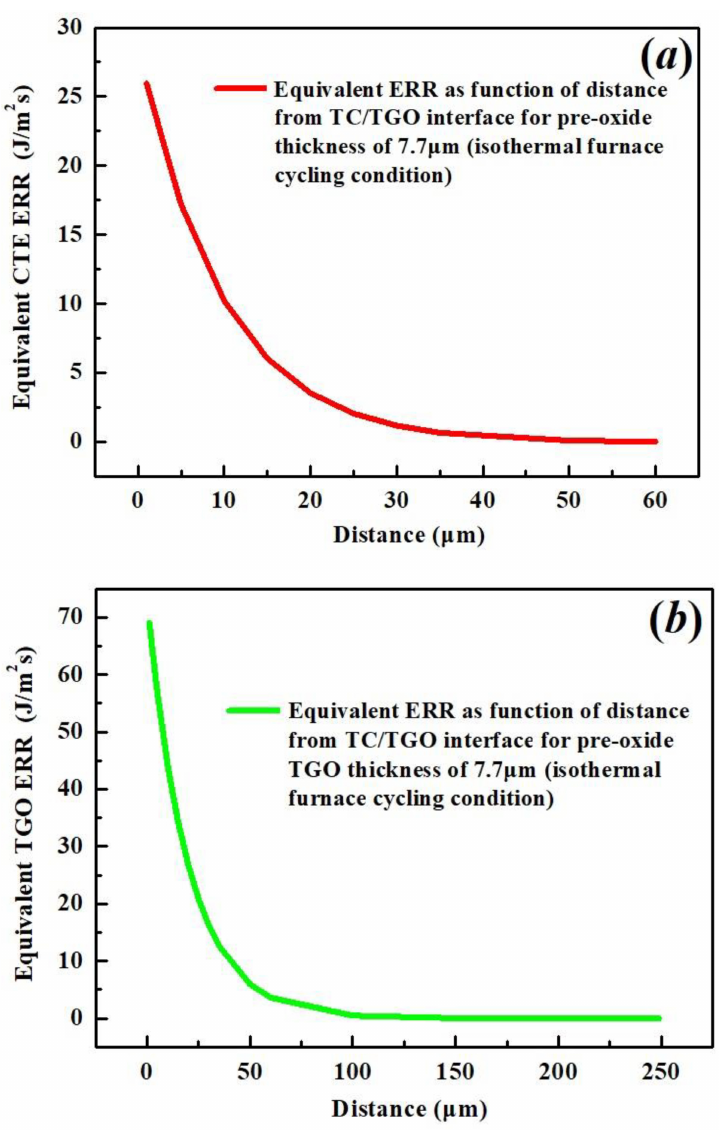
Figure 20. The calculated equivalent ERR vs. distance away from TC/TGO interface under iaothermal furnace cycling test due to ( a ) CTE misfit; ( b ) TGO